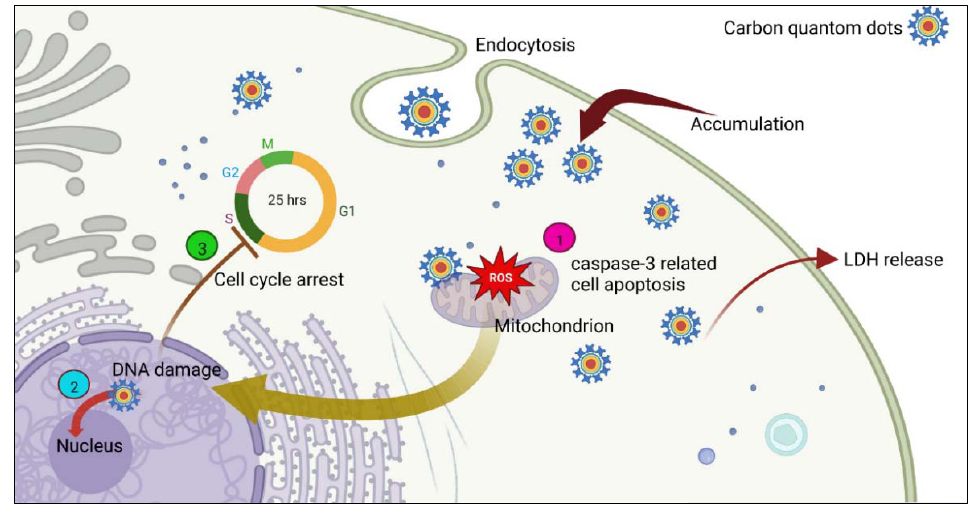
Figure 7. Schematic model to illustrate the proposed mechanisms of cell death induced by CQDs in breast cancer cells, based on recent studies [79–82]. (1) Increase in ROS levels, (2) DNA damage, (3) cell cycle arrest.